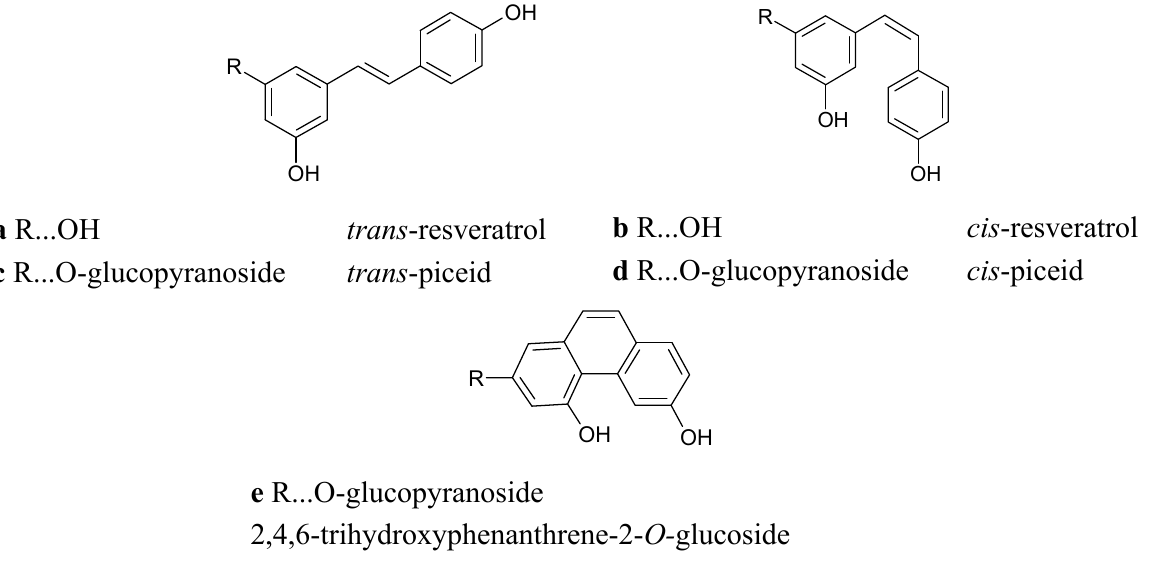
Figure 1. Chemical structures of the stilbene and phenanthrene